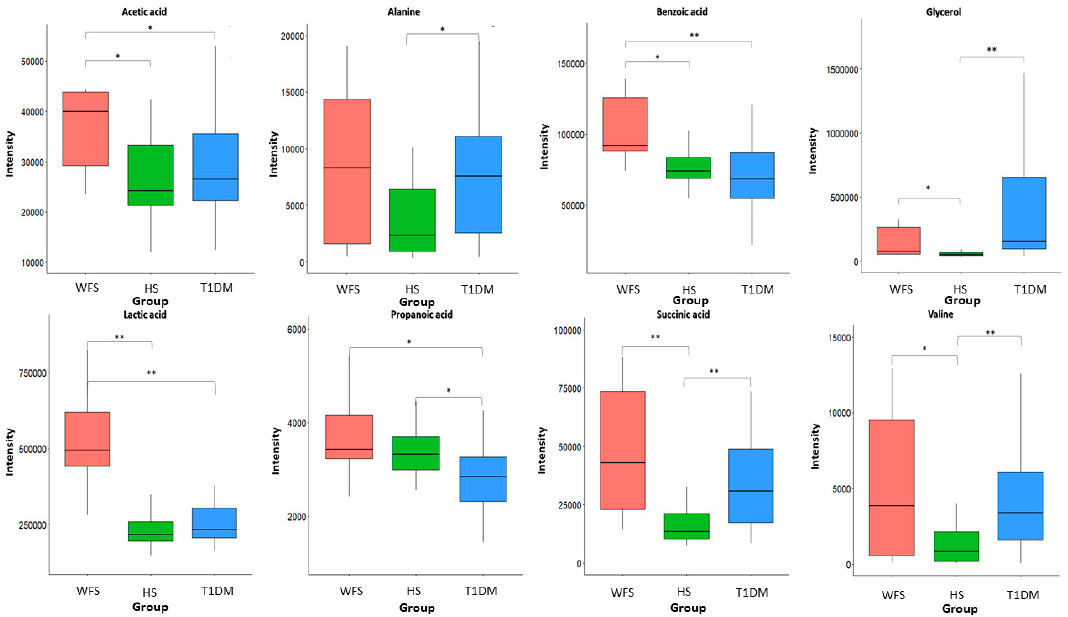
Figure 6. Levels of metabolites discriminating GCF samples of patients with WFS, T1DM, and healthy controls. Significant differences in metabolite intensity among the three groups were identified using a non-parametric Kruskal–Wallis ANOVA ( p < 0.05), followed by a Conover–Iman post-hoc test ( p < 0.05 *, <0.01 **). WFS—Wolfram syndrome; HS—healthy subjects; T1DM—Type 1 diabetes mellitus.